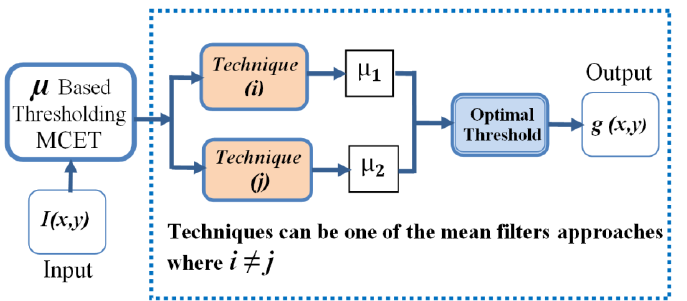
Figure 2. Proposed thresholding framework, where µ 1 is estimated using technique ( i ) and µ 2 is estimated using technique ( j ) and i ≠ j .